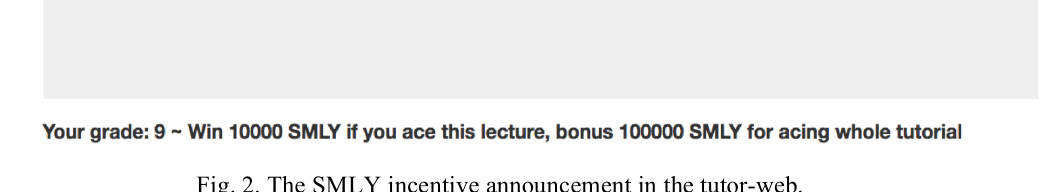
Fig. 2. The SMLY incentive announcement in the tutor-web.